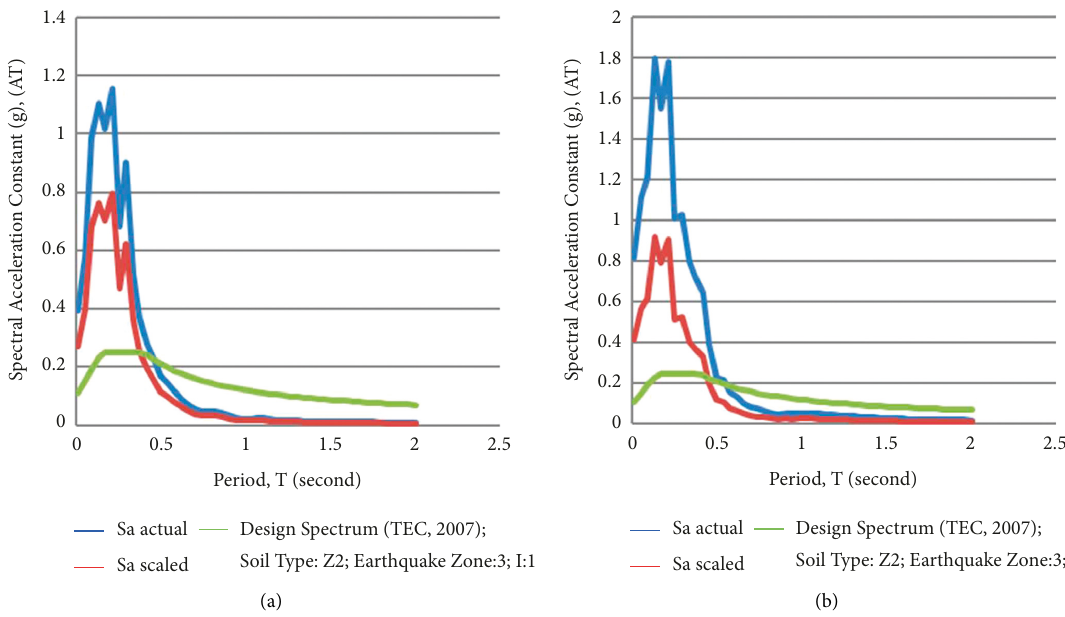
Figure 24: Evaluation of A(T) spectral acceleration constants for (a) North-South (N-S) and (b) East-West (E-W) components of earthquake with epicenter at Sivas-Kangal ( M W : 4.2).